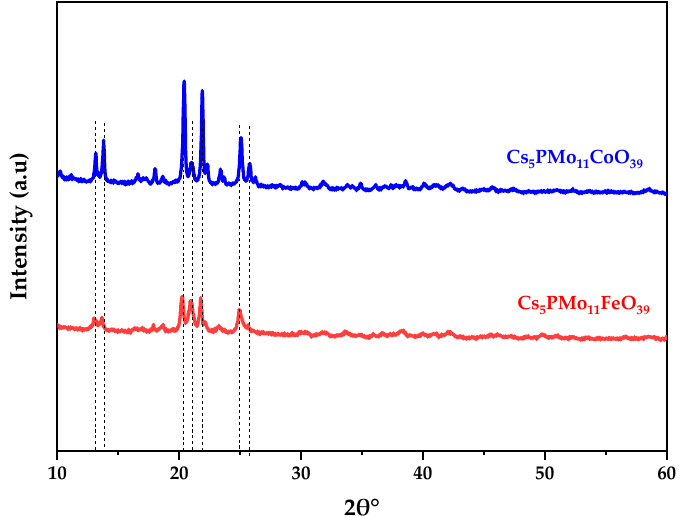
Figure 1. X-ray diffractograms of Cs 5 PMo 11 FeO 39 and Cs 5 PMo 11 CoO 39.